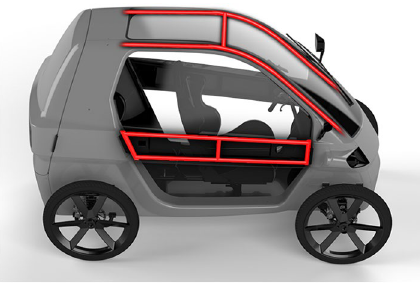
Fig. 6 SNAP safety